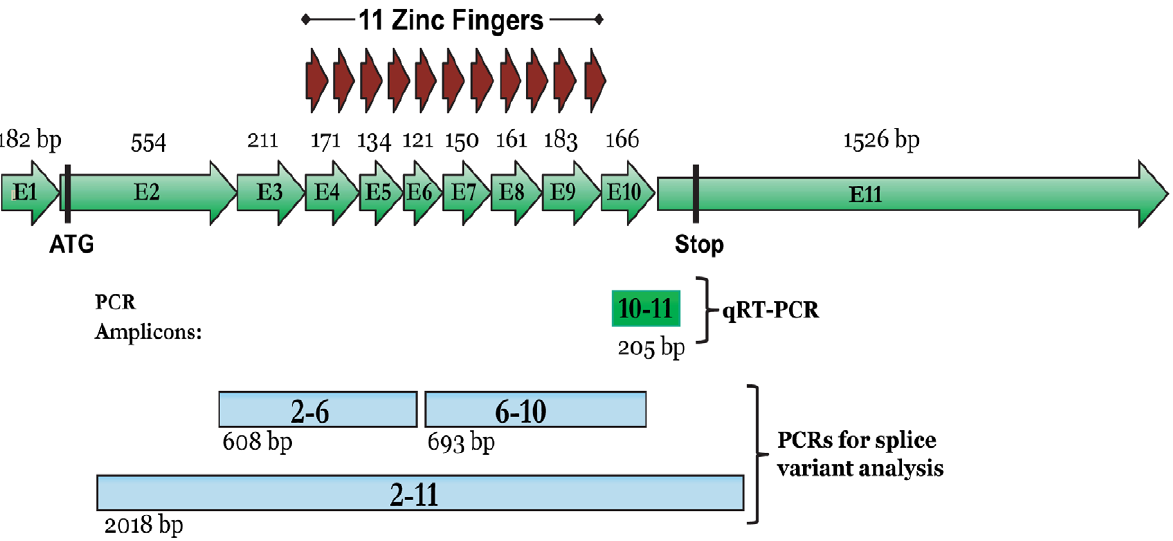
Figure 1. BORIS mRNA and PCR design. The eleven exons of BORIS mRNA (ENSEMBL # ENST00000243914, CTCFL), and their corresponding sizes (base pairs) are depicted as green arrows. The ATG start codon, area encoding the eleven zinc fingers (red arrows), and TGA stop codon are marked for reference. The areas and sizes of the real-time PCR amplicon (10-11; bright-green box), and end-point PCR amplicons (2–6, 6–10, 2–11; blue boxes) used to detect alternatively spliced variants, are indicated.